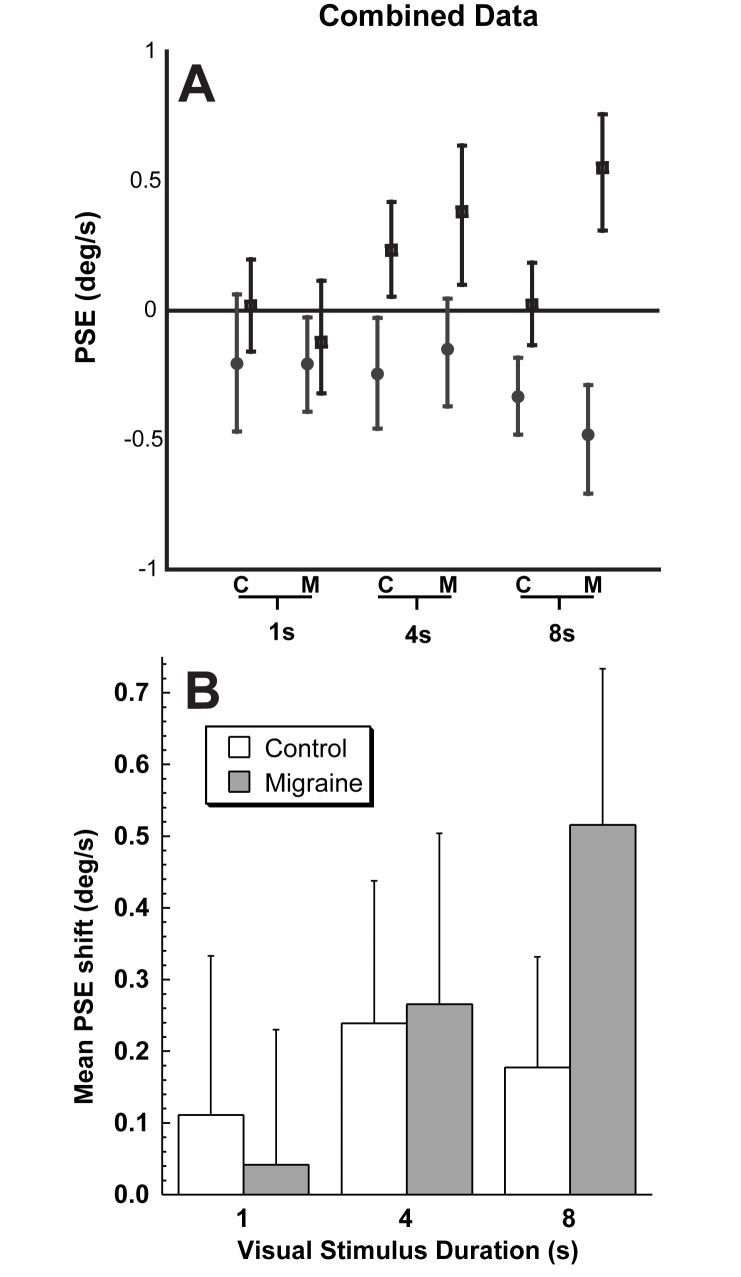
Combined subject data by population and trial.Panel A: Counterclockwise VFM is represented with filled circles, clockwise VFM with open squares. A positive PSE indicates that a neutral motion would be more likely to be perceived as clockwise self-motion, likewise a negative PSE indicates a neutral motion would be perceived as counterclockwise. Error bars represent 95% CI. Panel B: Both directions are combined to show the mean shift. Control subjects are represented by open bars and migraineurs by filled bars.